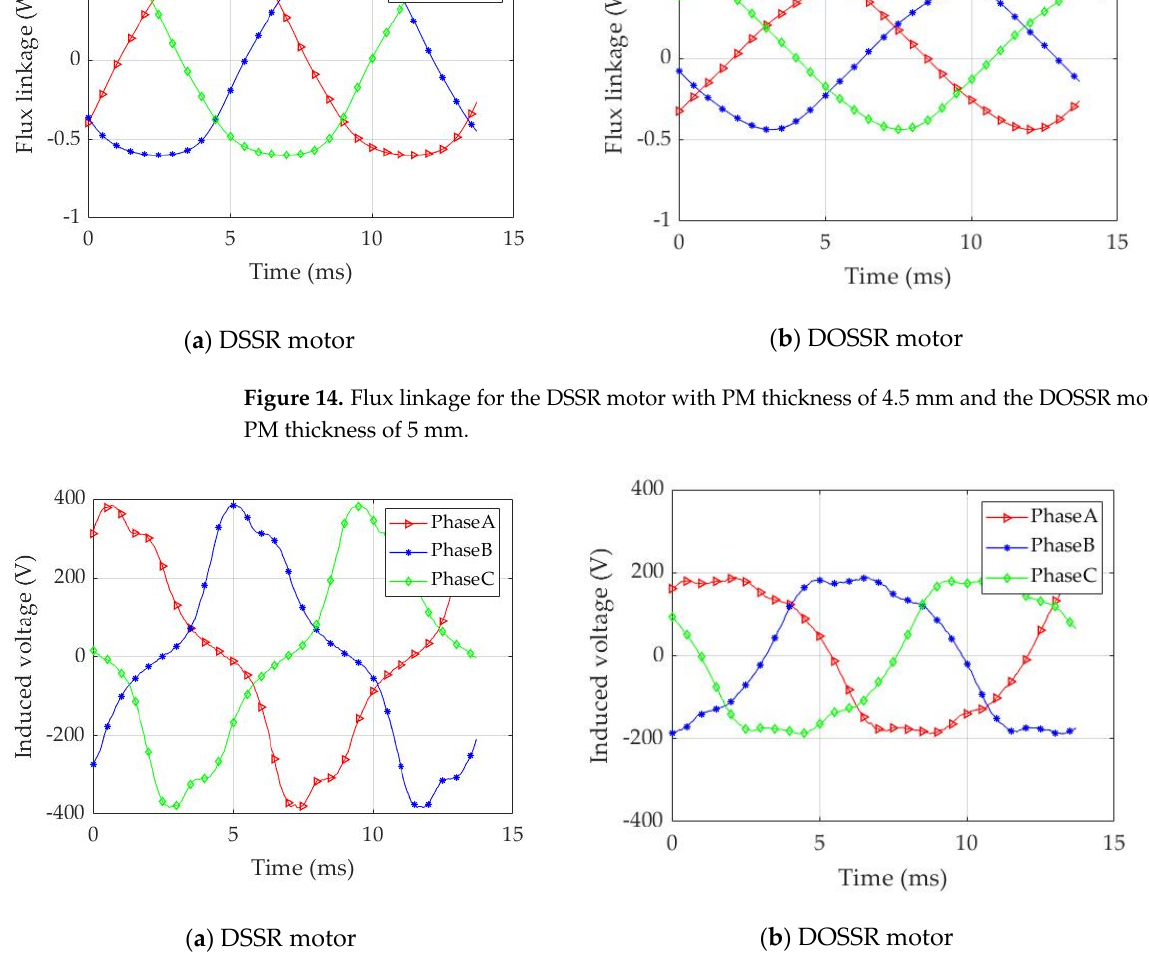
Figure 15. Induced voltage for the DSSR motor with PM thickness of 4.5 mm and the DOSSR motor with PM thickness of 5 mm.